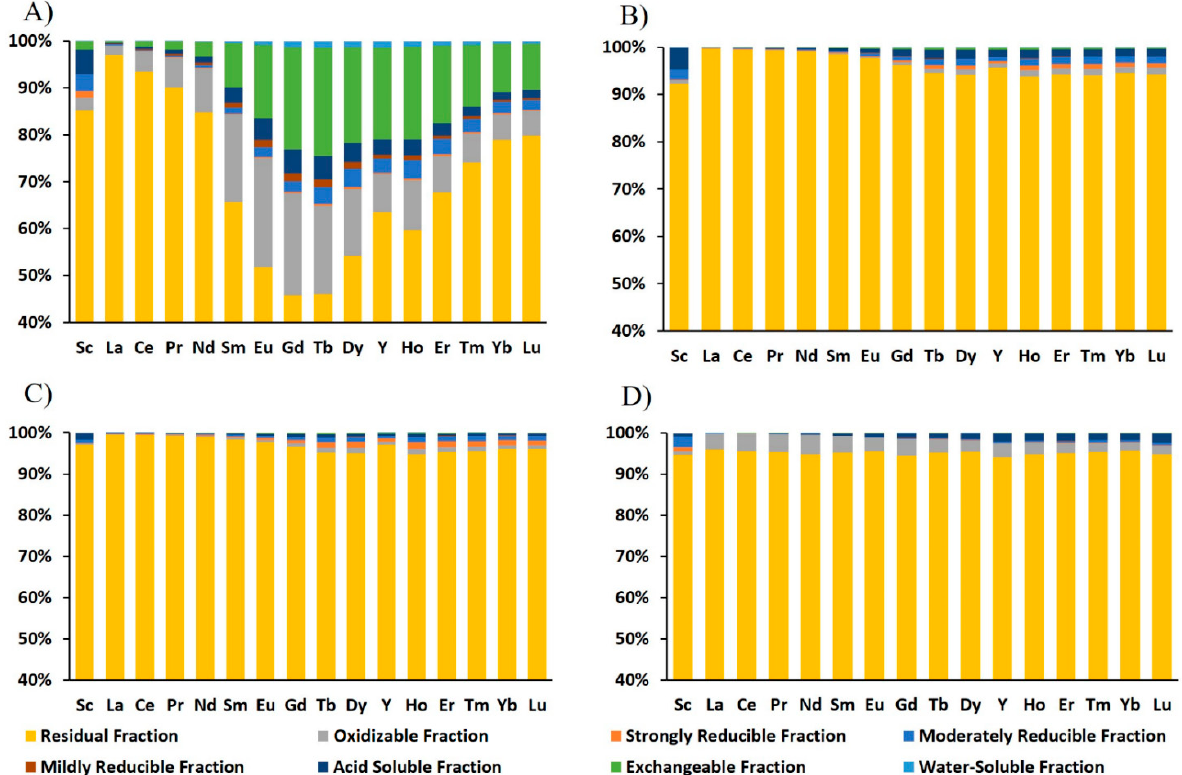
Figure 7. ( A ) Distribution of REE in WV MKT underclay normalized to percentage extraction. ( B ) Distribution of REE in WV MKT coarse coal refuse normalized to percentage extraction. ( C ) Distribution of REE in Central PA LKT underclay normalized to percentage extraction. ( D ) Distribution of REE in Central PA MKT underclay normalized to percentage extraction.